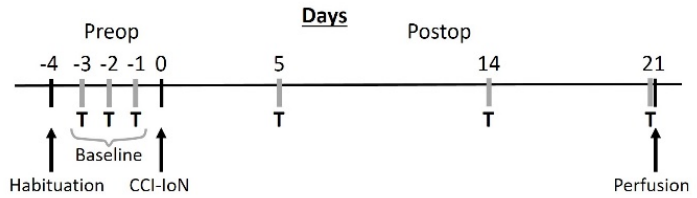
Figure 9. Schematic diagram of the experimental protocol. T, behavioral testing; CCI-IoN, constriction of the IoN.